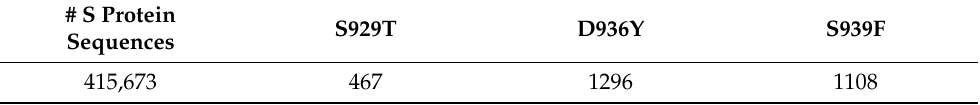
Table 1. Occurrences of most frequent mutations on the HR1 “fusion core” on 15 February 2021.